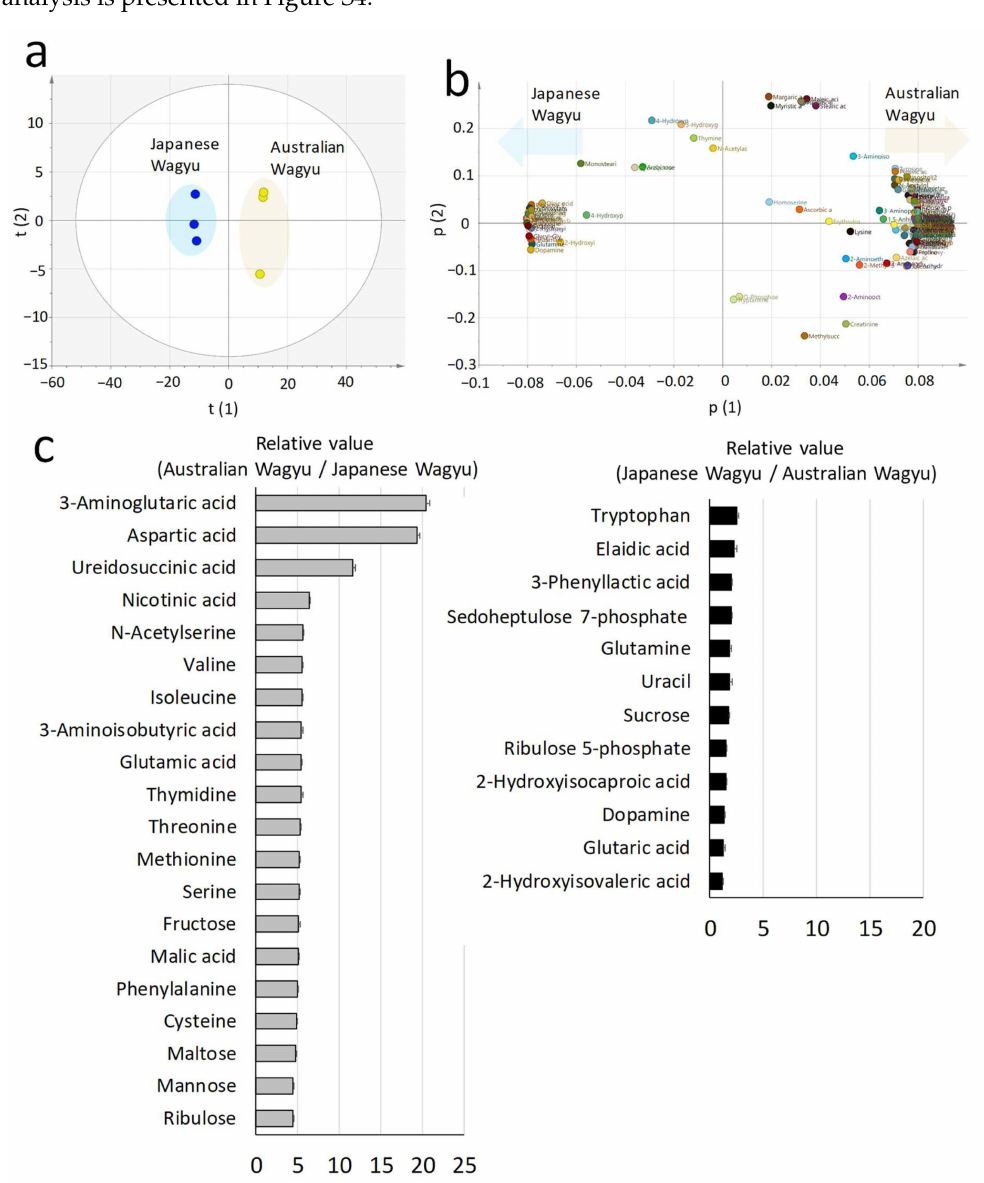
Figure 5. Comparison by metabolomics analysis. The figure presents the principal component analysis (PCA) results of the nutrients detected during the metabolomics analysis of the